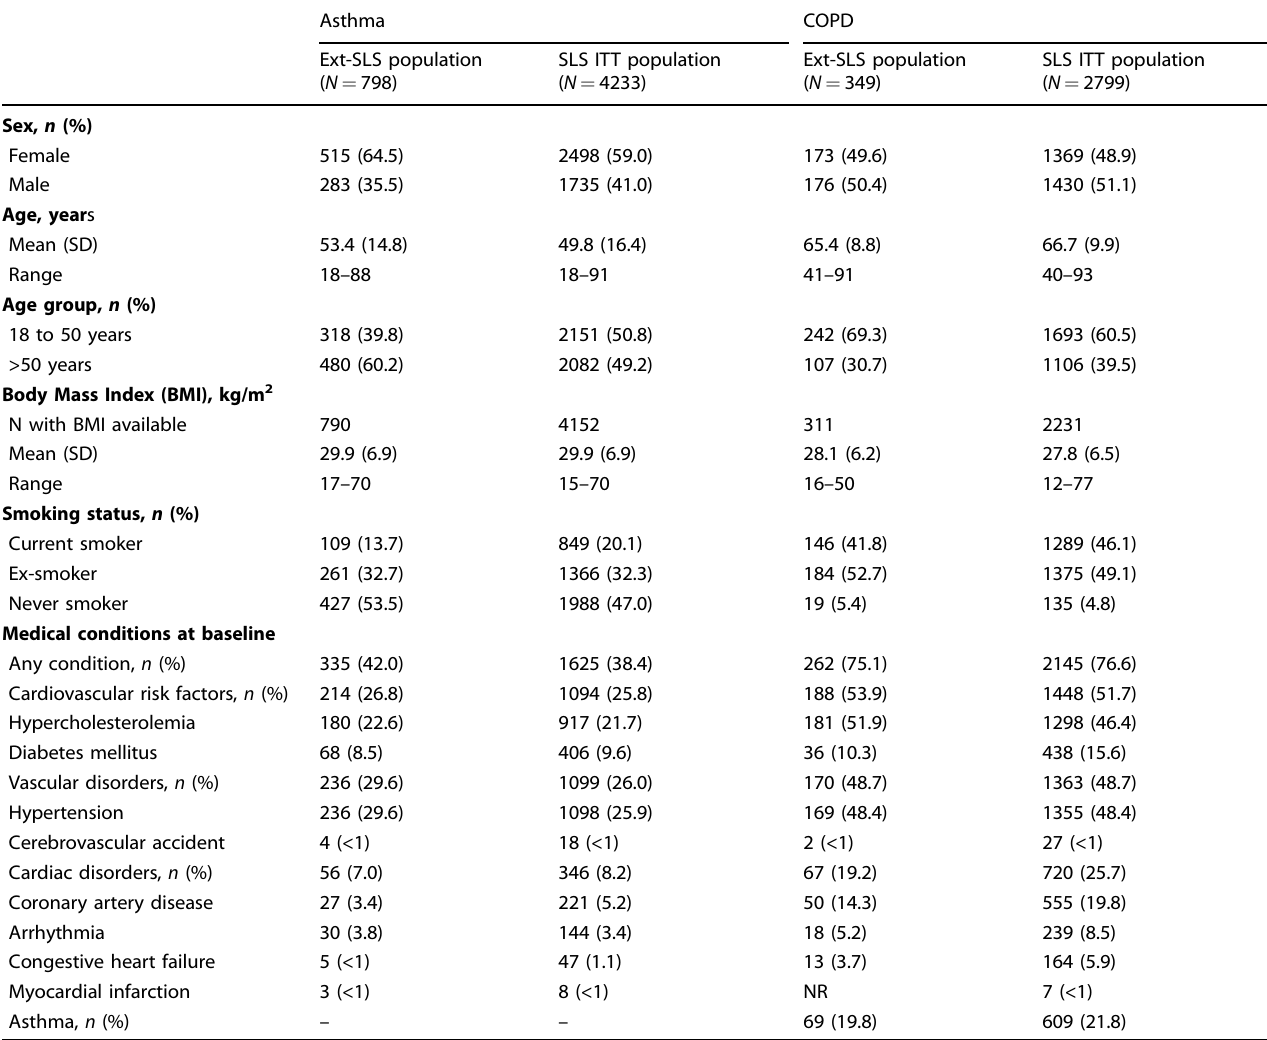
Table 2. Baseline characteristics of the Ext-SLS cohort and SLS ITT populations, as recorded at the time of entry into the